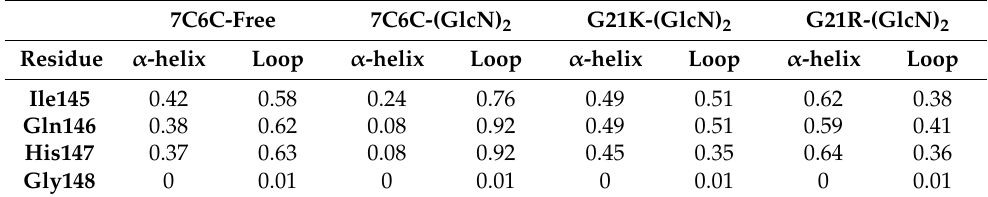
Table 1. Probability of α -helix in Ile145-Gly148 during 100 ns MD simulations.